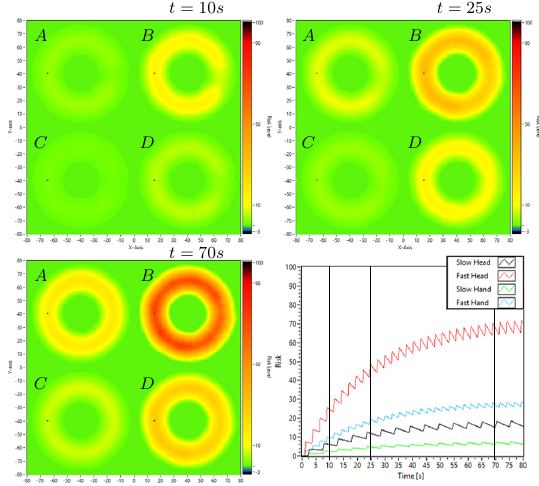
Figure 7: Simulated human activity with constant visit frequency over time. A=Slow Head, B= Fast Head, C=Slow Hand, D= Fast Hand. The lines on the graph indicate sample times